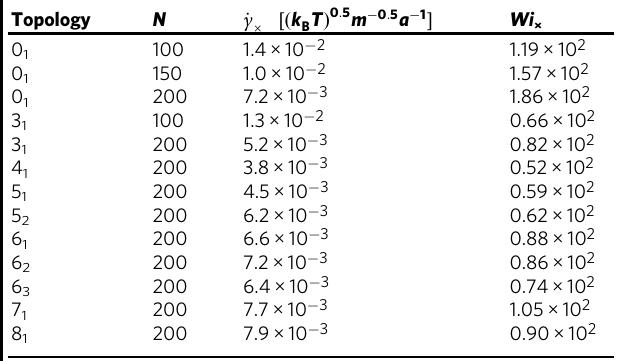
Table 1 Crossover shear rates _ γ ´ and Weissenberg numbers Wi × from tumbling to in